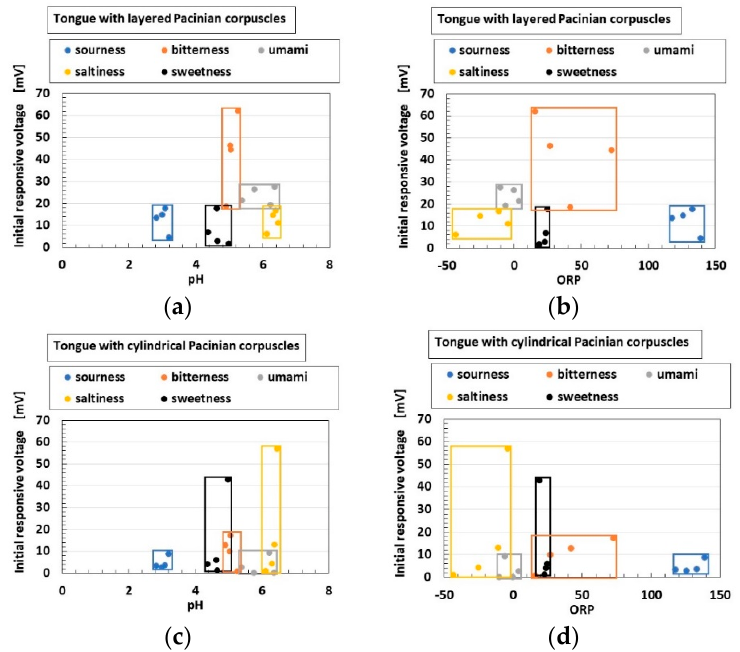
Figure 15. Experimental results of initial response voltage to five tastes: ( a ), ( b ) for layered Pacinian corpuscles; ( c ), ( d ) for cylindrical Pacinian corpuscles; ( a ), ( c ) by pH; ( b ), ( d ) by ORP.